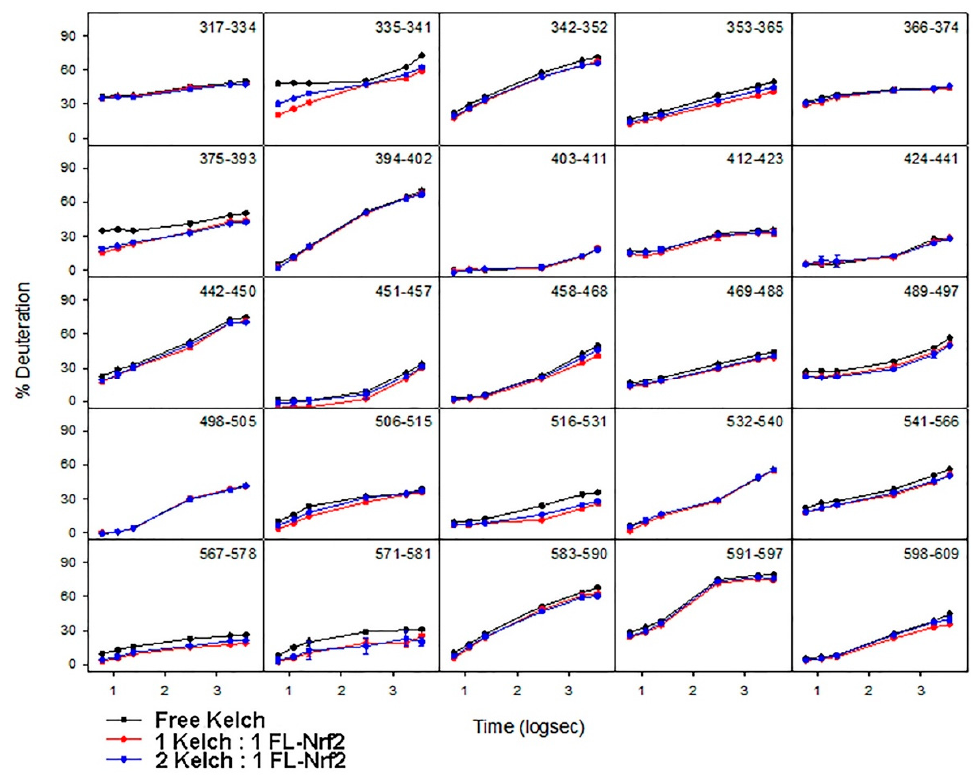
Figure 6. HDX-MS kinetic plots for free Kelch (black), 1:1 (red), and 2:1 (blue) Kelch:FL-Nrf2. To understand the effect of Nrf2-binding on the global dynamics of Kelch, the HDX difference of the 1:1 state was plotted at time points 0.1, 0.4, and 30 min compared to free Kelch (Figure 7). At 0.1 and 0.4 min, a large reduction in deuterium uptake was observed in peptides 375–393, consistent with hydrogen bond formation of this site when the Kelch domain interacts with FL-Nrf2. Overall, the data show that there is a general stabilization of the entire Kelch domain upon binding to FL-Nrf2.